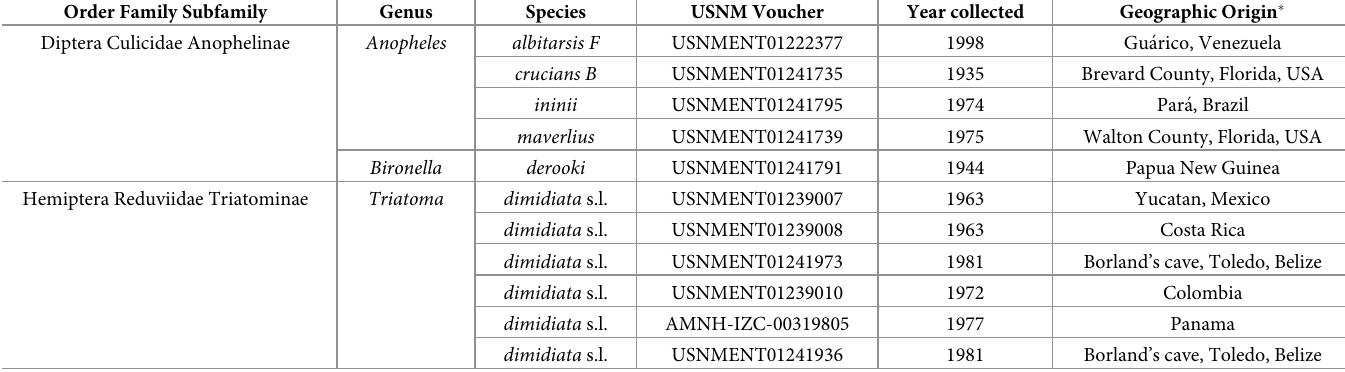
Table 1. Specimens used in this study, their voucher number at USNM and the year of collection. Geographic origins are listed verbatim from the archive specimen labels. Order Family Subfamily Genus Species USNM Voucher Year collected Geographic Origin � Diptera Culicidae Anophelinae Anopheles albitarsis F crucians B